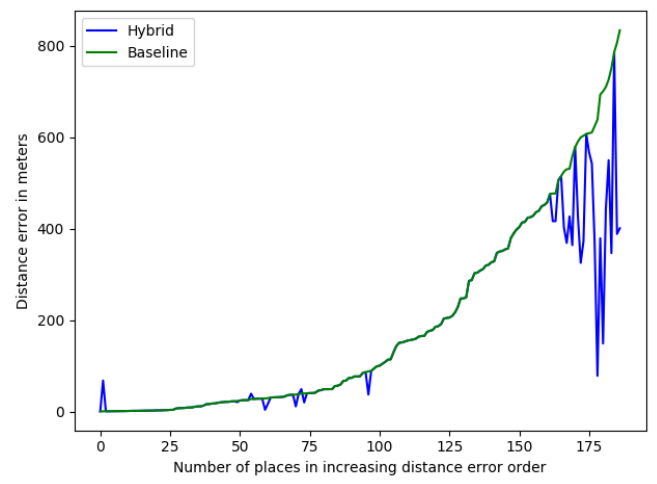
Figure 15. Distance errors between ground-truth and matched gazetteer locations for the baseline and hybrid methods.